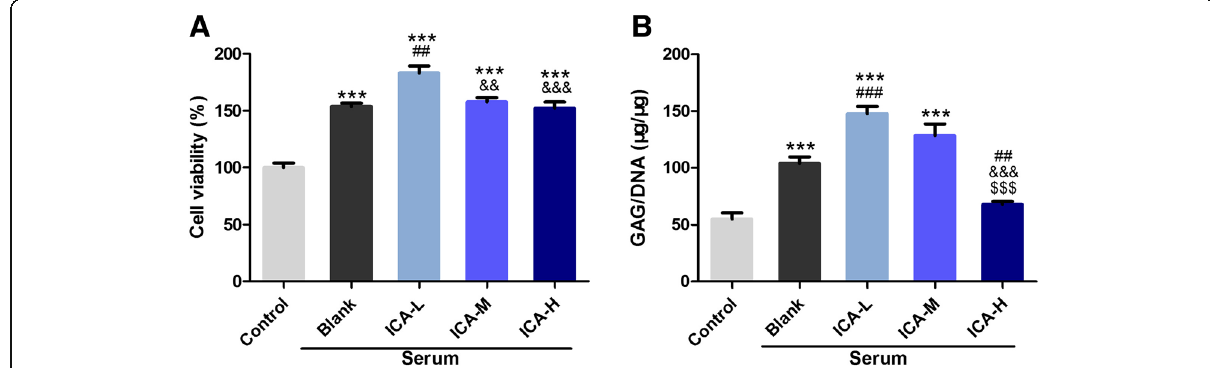
Fig. 2 DCS of low concentration could promote the proliferation of chondrocytes. ( n = 6, mean ± SD). a MTT assay of the proliferation rates of chondrocytes incubated with DCS of different concentrations. b GAG contents of chondrocytes treated by DCS of different concentrations. *** P < 0.001 vs Control; ## P < 0.01, ### P < 0.001 vs Blank Serum; && P < 0.01, &&& P < 0.001 vs ICA-L, $$$ P < 0.001 vs ICA-M. Abbreviations: DCS, drug conditioned serum; GAG, glycosaminoglycan; MTT, methyl thiazolyl tetrazolium; SD, standard deviation. ICA-L refers to group treated with low dose icariin conditioned serum, ICA-M refers to group treated with middle dose icariin conditioned serum, ICA-H refers to group treated with high dose icariin conditioned